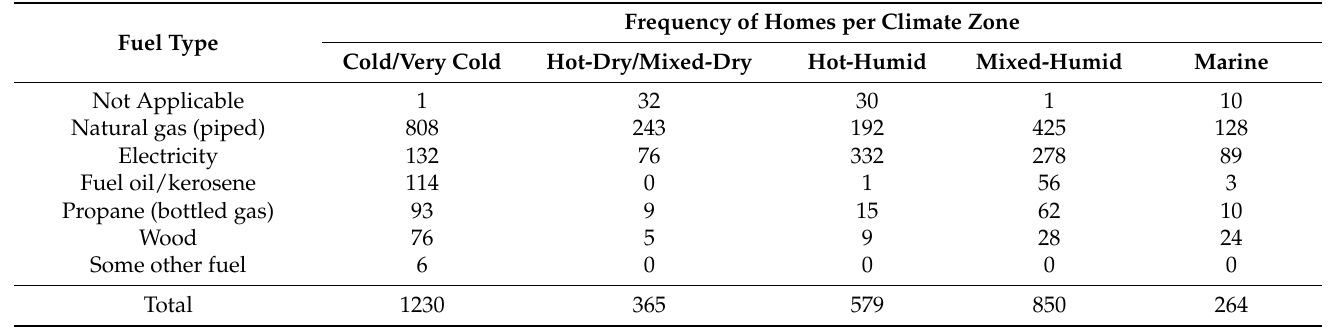
Table 2. Fuel used on main heating equipment per climate zones (total n =